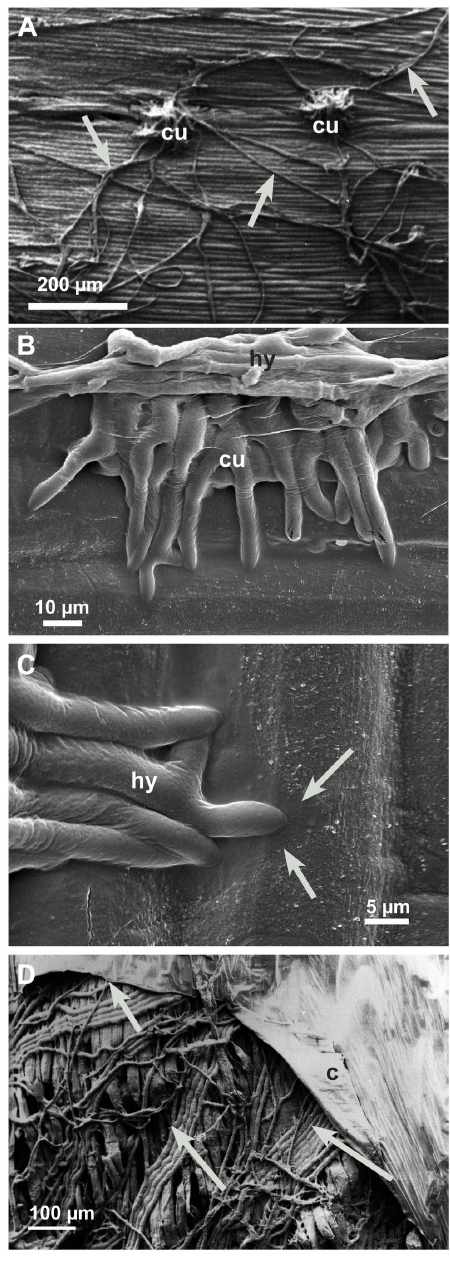
Figure 2. Development of early infection structures (12-24 hpi). Infection cushions, running hyphae on the epidermis of hypocotyls, and subcuticular hyphae investigated by scanning electron microscopy. A : Dome-shaped infection cushion (cu) and running hyphae (arrows); conventional SEM. B : Young infection cushion (cu) overgrown by running hyphae (hy); LTSEM. C : Detail of Figure 2B. Hyphae (hy) of the infection cushion attached to the cuticle of the epidermis. Hyphal exudates (arrows) covering wax crystals of the cuticle in LTSEM. D : After penetration, when the cuticle (c) is detached from the epidermal layer the parallel growing subcuticular hyphae (arrows) become visible in conventional SEM. doi: 10.1371/journal.pone.0072292.g002 PLOS ONE |